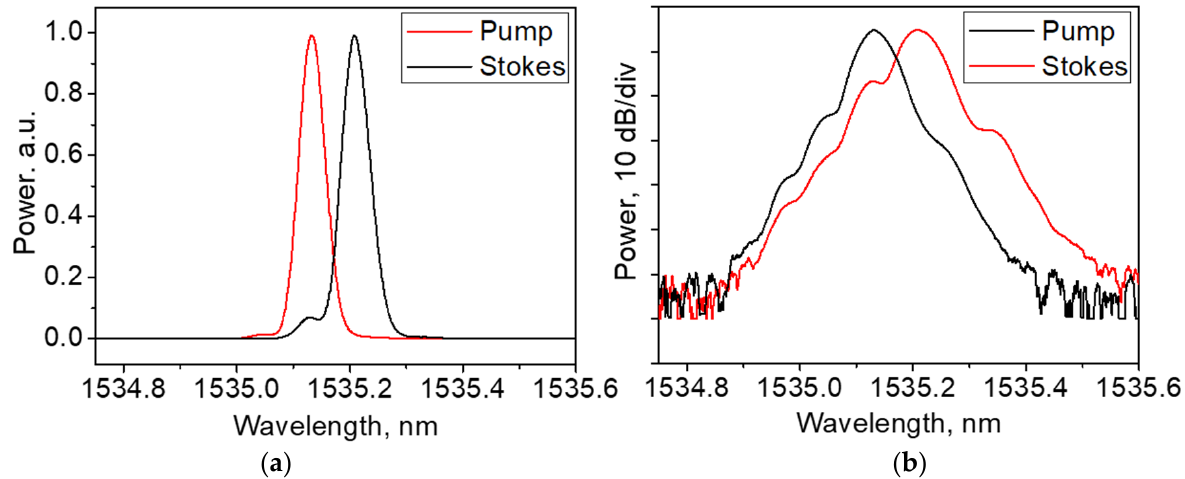
Figure 2. Optical spectra recorded at two laser outputs in ( a ) linear and ( b ) decibel scales.